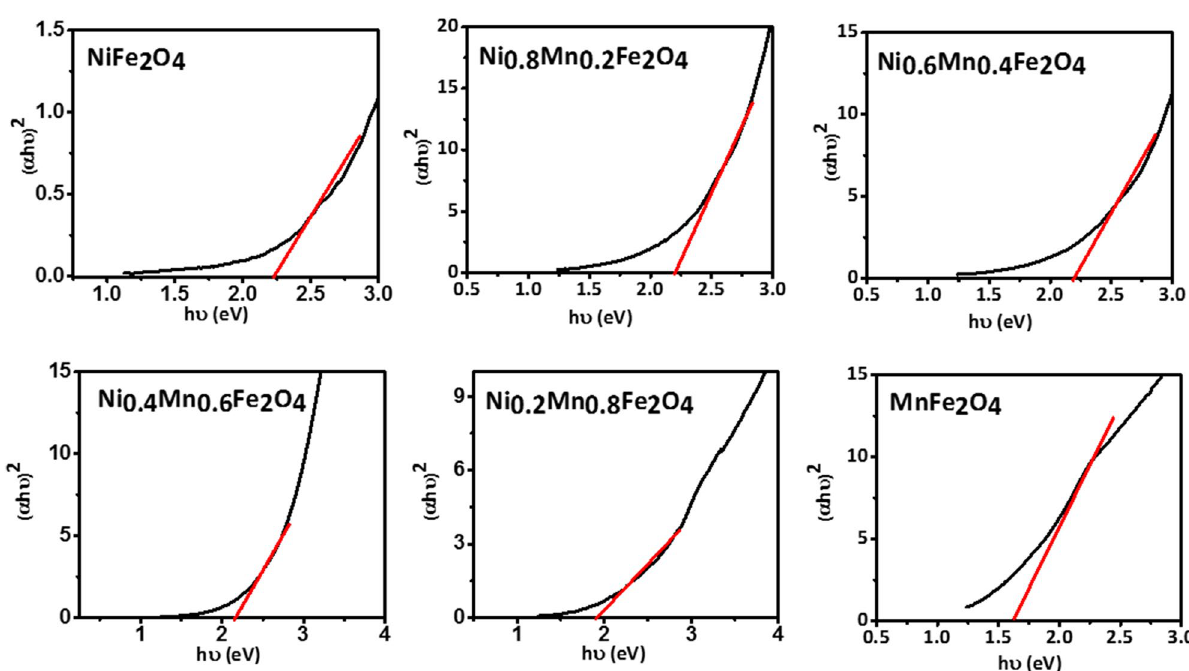
Figure 5. Tauc plots of the Ni 1− x Mn x Fe 2 O 4 nanoparticles assuming direct